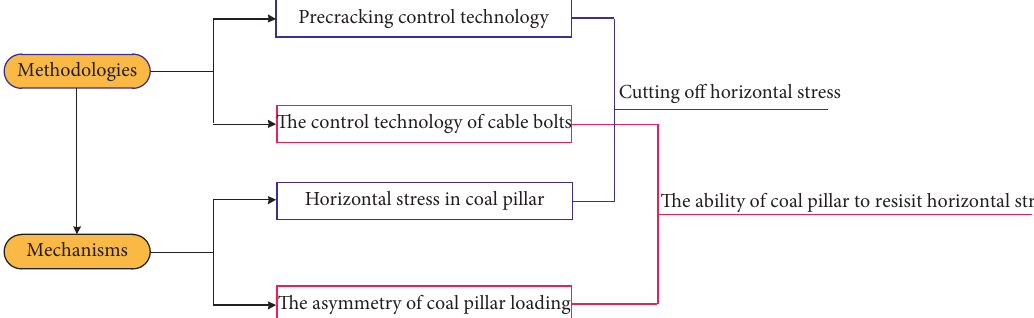
Figure 15: Proposed methods for controlling floor heave in the RAG.